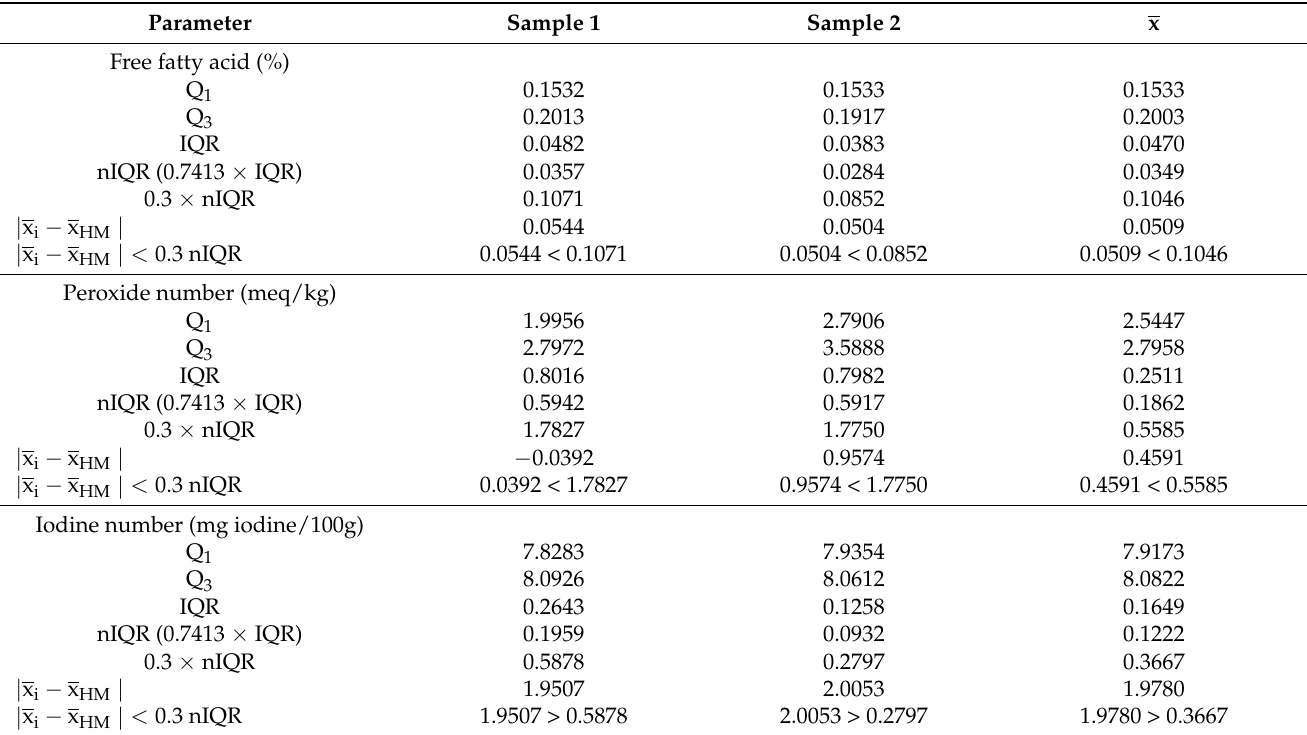
Table 5. The data for stability test of free fatty acid.